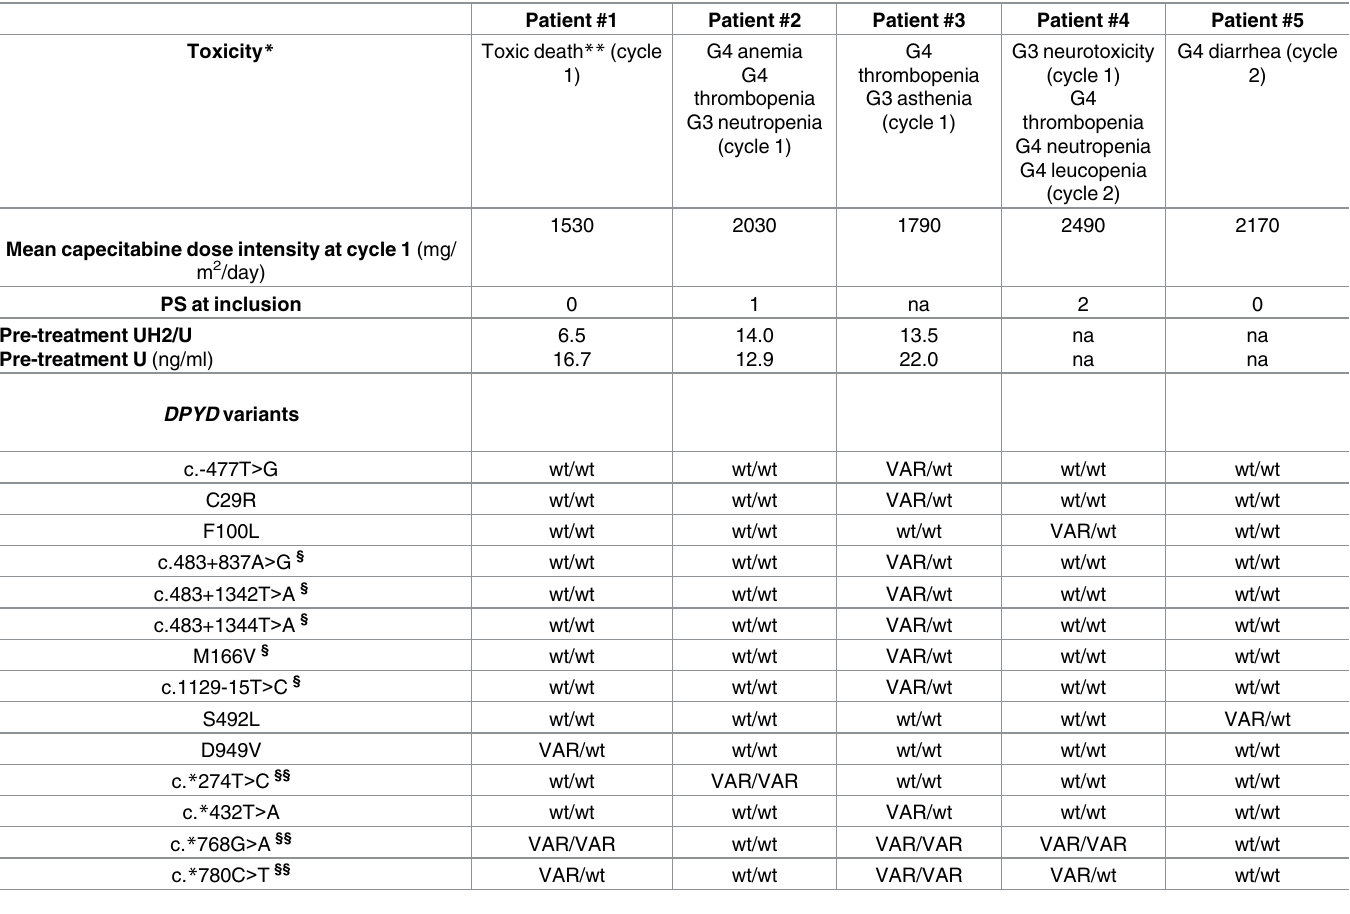
Table 2. Profile of patients with grade 4–5